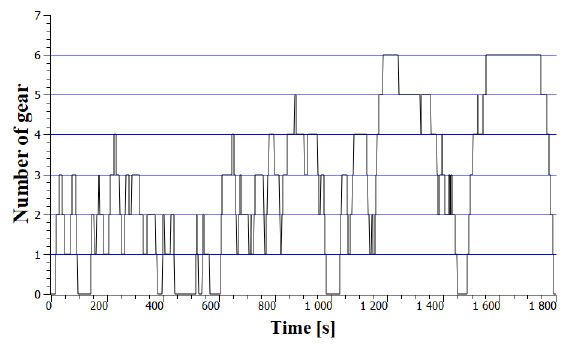
Fig. 6. Calculated gear gearshift strategies